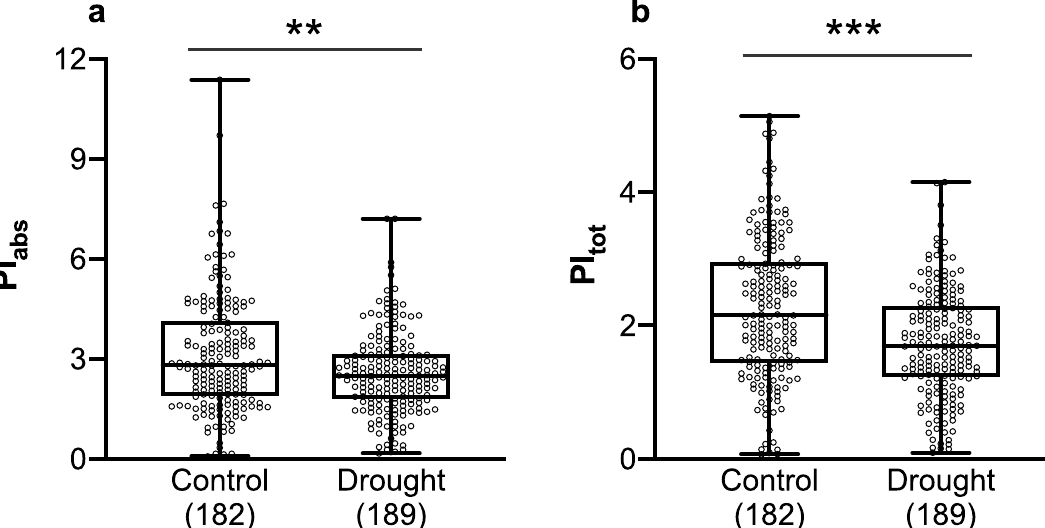
Figure 1. Chlorophyll fluorescence parameters PI abs ( a ) and PI tot ( b ) measured in the control and drought treated saplings. ** P < 0.01; *** P < 0.001. Box plots present median, upper, and lower quartiles; whiskers show minimum and maximum values. Sample size is presented in